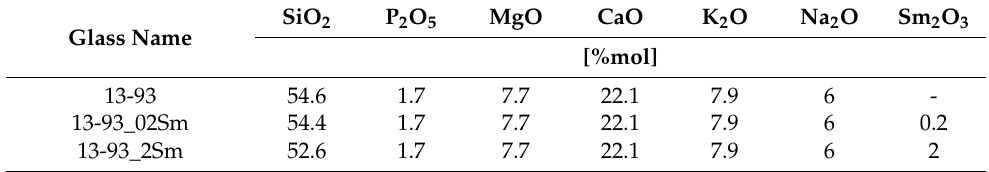
Table 1. The molar composition of investigated glass